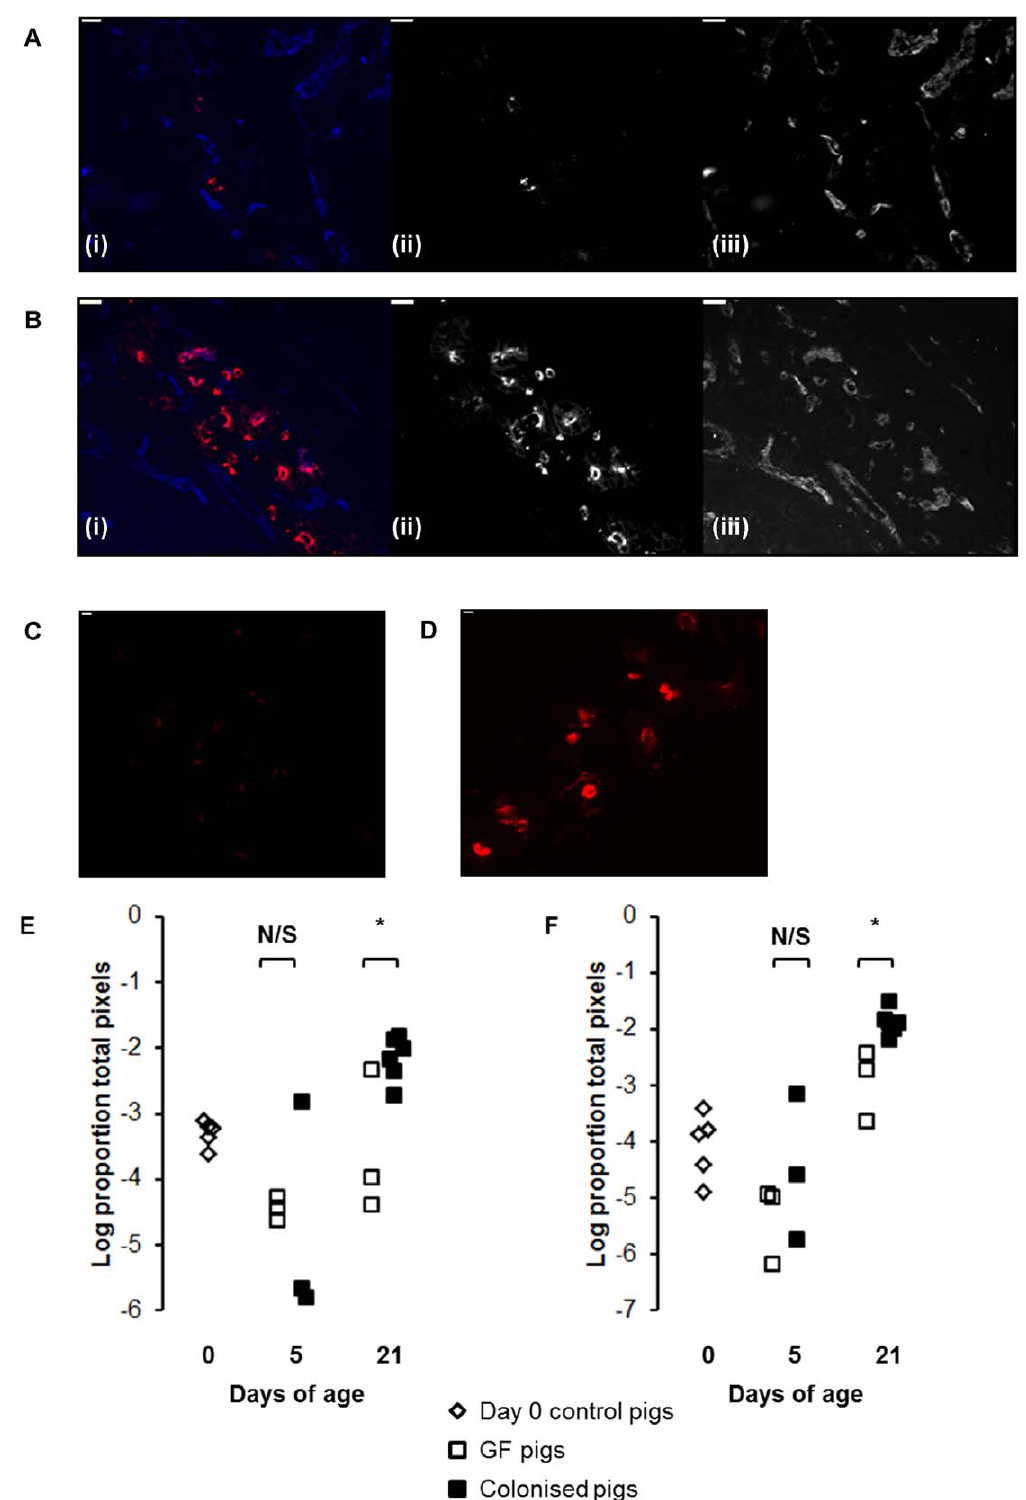
Figure 1. Colonisation expands IgM and IgA-producing mucosal plasma cells. (A) IgA staining in jejunal mucosa from a GF pig and (B) a colonised pig at 21 days of age. Sections were stained with antibodies to IgA (red) and capillary endothelium (MIL11; in blue). In both (A) and (B), (i) shows the two-colour image; (ii) shows the original greyscale image for the red channel (IgA); (iii) shows the original greyscale image for the blue channel (endothelium). Scale bar represents 10 m m. (C) IgM staining in jejunal mucosa from a GF pig and (D) a colonised pig at 21 days of age. Sections were stained with antibodies to IgM (red). Scale bar represents 10 m m. (E) Area of IgM and (F) IgA staining in jejunal sections from piglets at birth (open diamonds) and GF piglets (open squares) and colonised piglets (black squares) at 5 and 21days of age (see Table 1 for numbers of piglets in each experiment). * p , 0.01. doi:10.1371/journal.pone.0033707.g001 PLoS ONE |